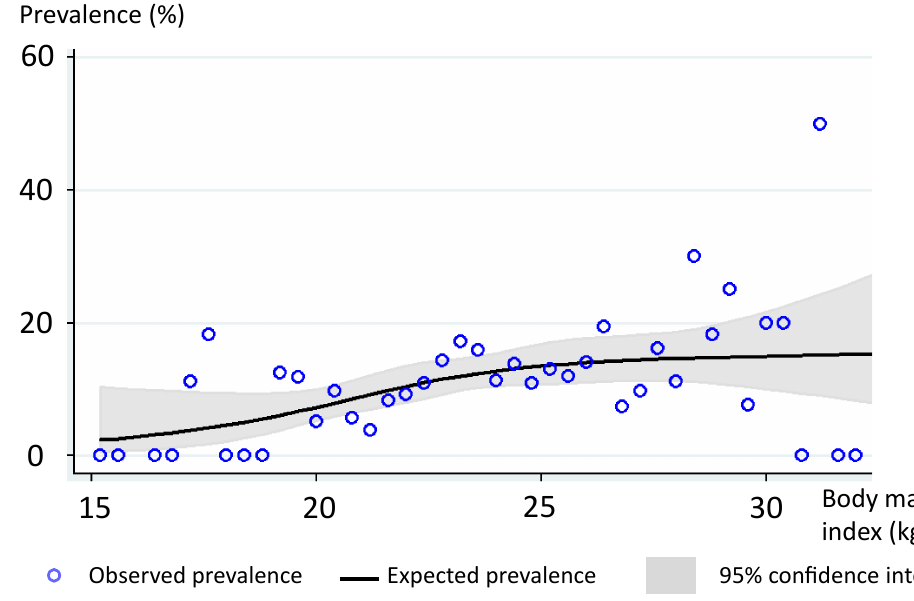
Figure. The prevalence of paranasal sinus disease according to body mass